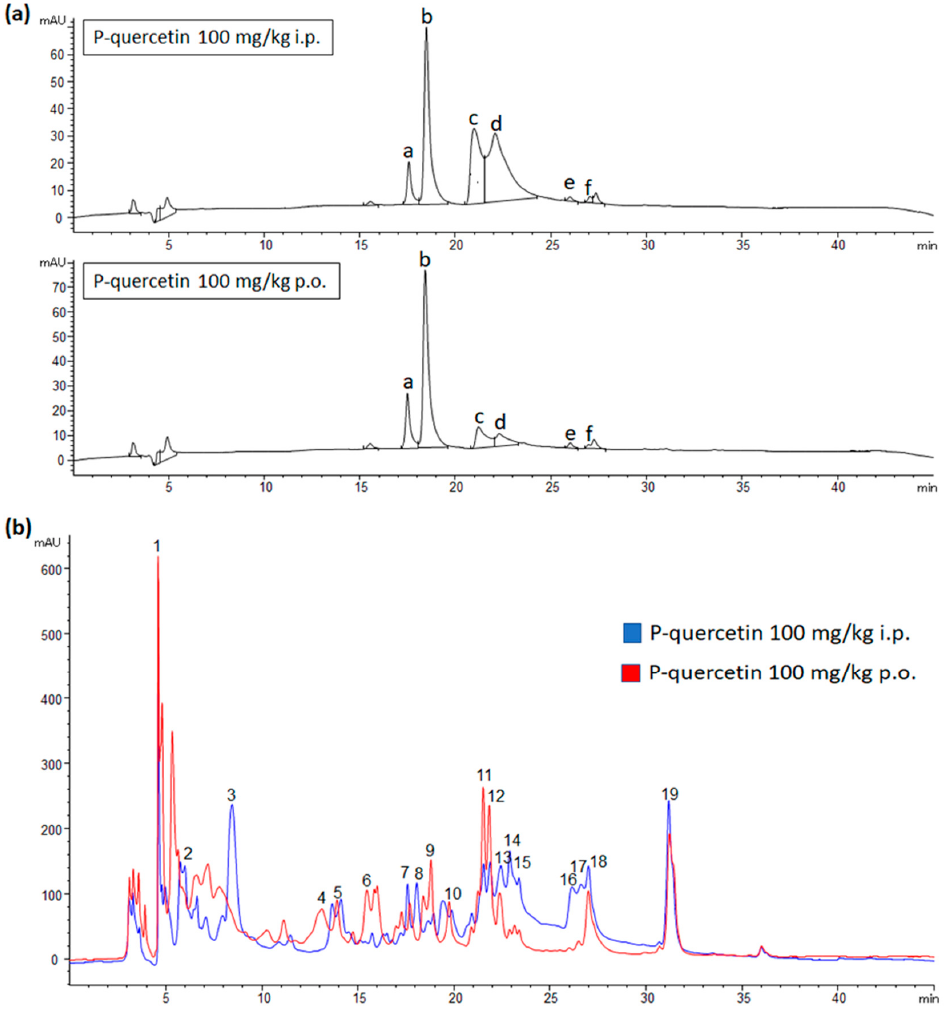
Figure 2. HPLC chromatograms recorded at 360 nm of plasma ( a ) and urine ( b ) samples from